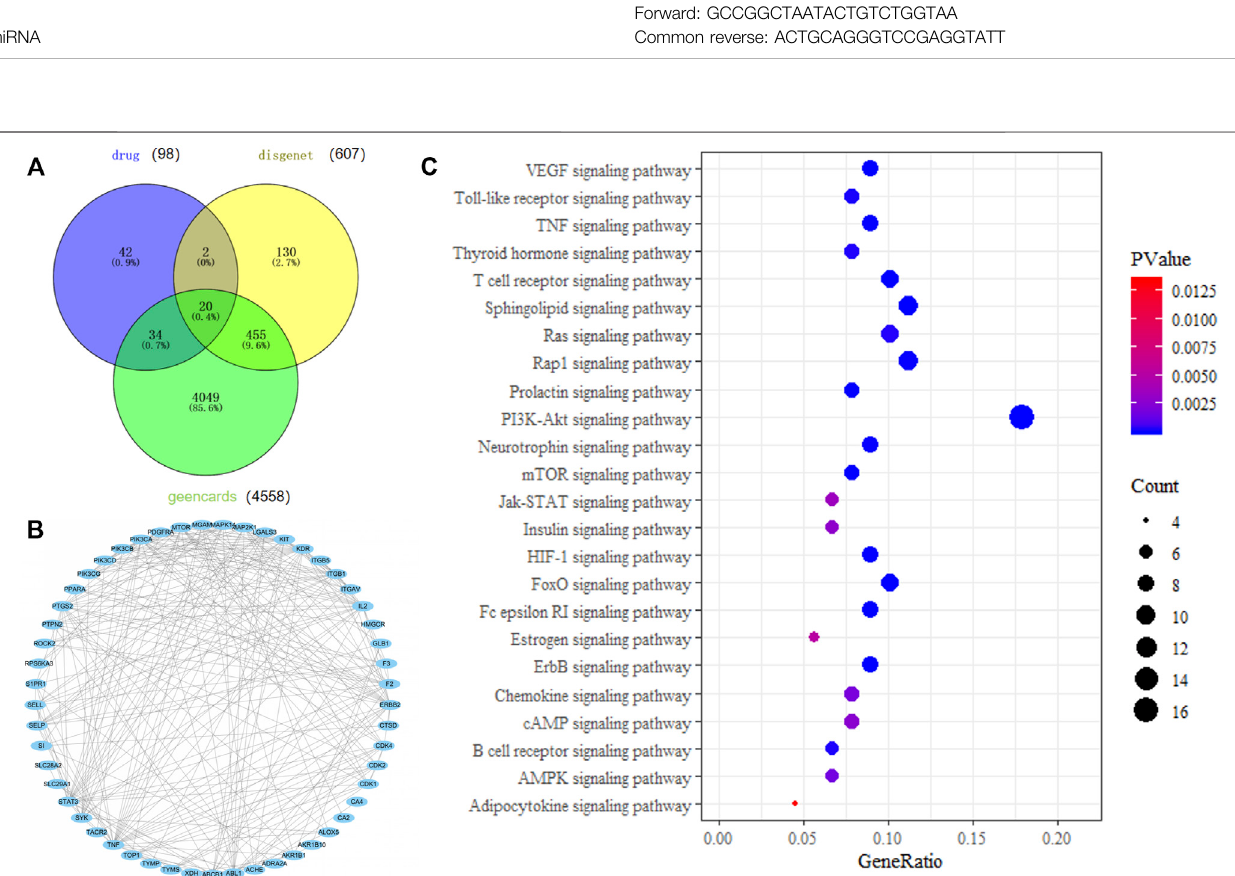
Frontiers in Pharmacology |